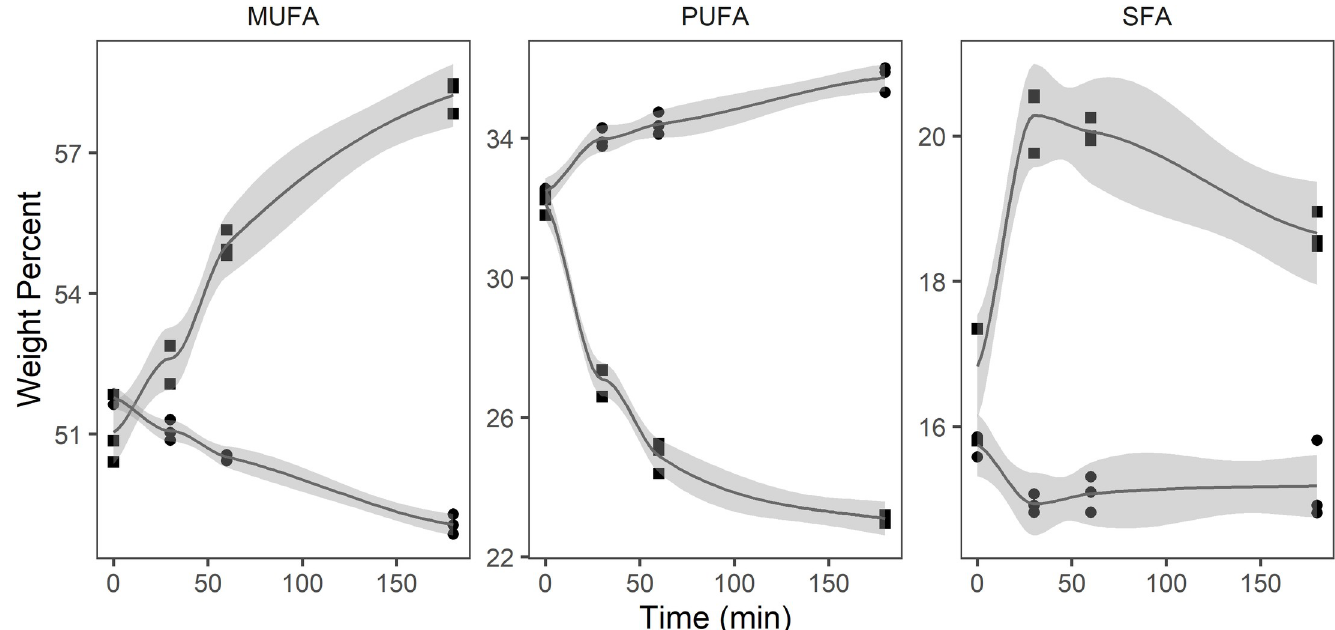
Fig 3. Monounsaturated fatty acids (MUFA), polyunsaturated fatty acids (PUFA), and saturated fatty acids (SFA) (weight percent) in free fatty acid (square) and neutral lipid (circle) fraction of cod-liver oil (n = 3) during in vitro digestion.